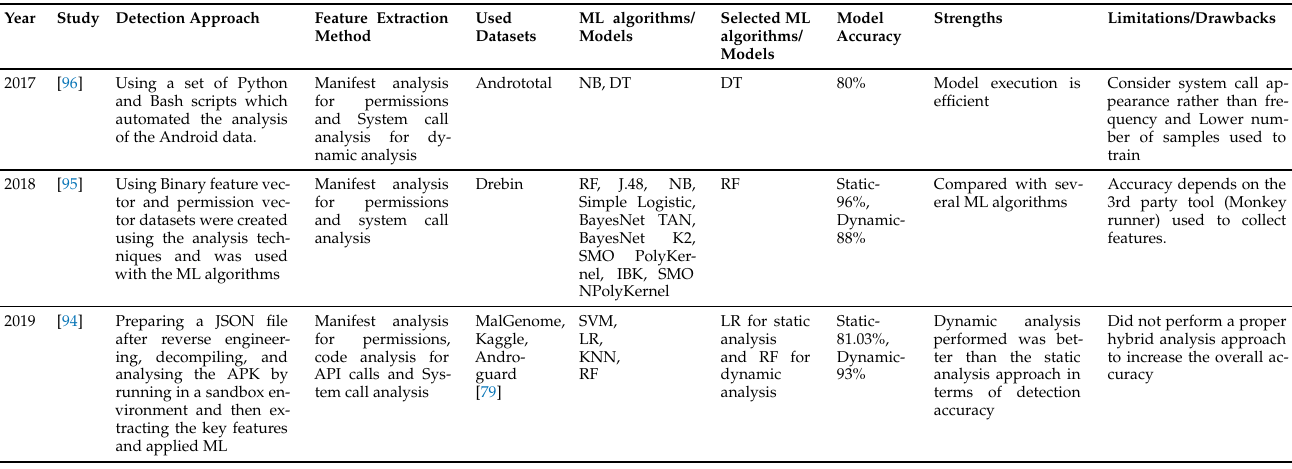
Table 6. Hybrid analysis based malware detection approaches (model accuracy is below 90% or overall accuracy is not available).